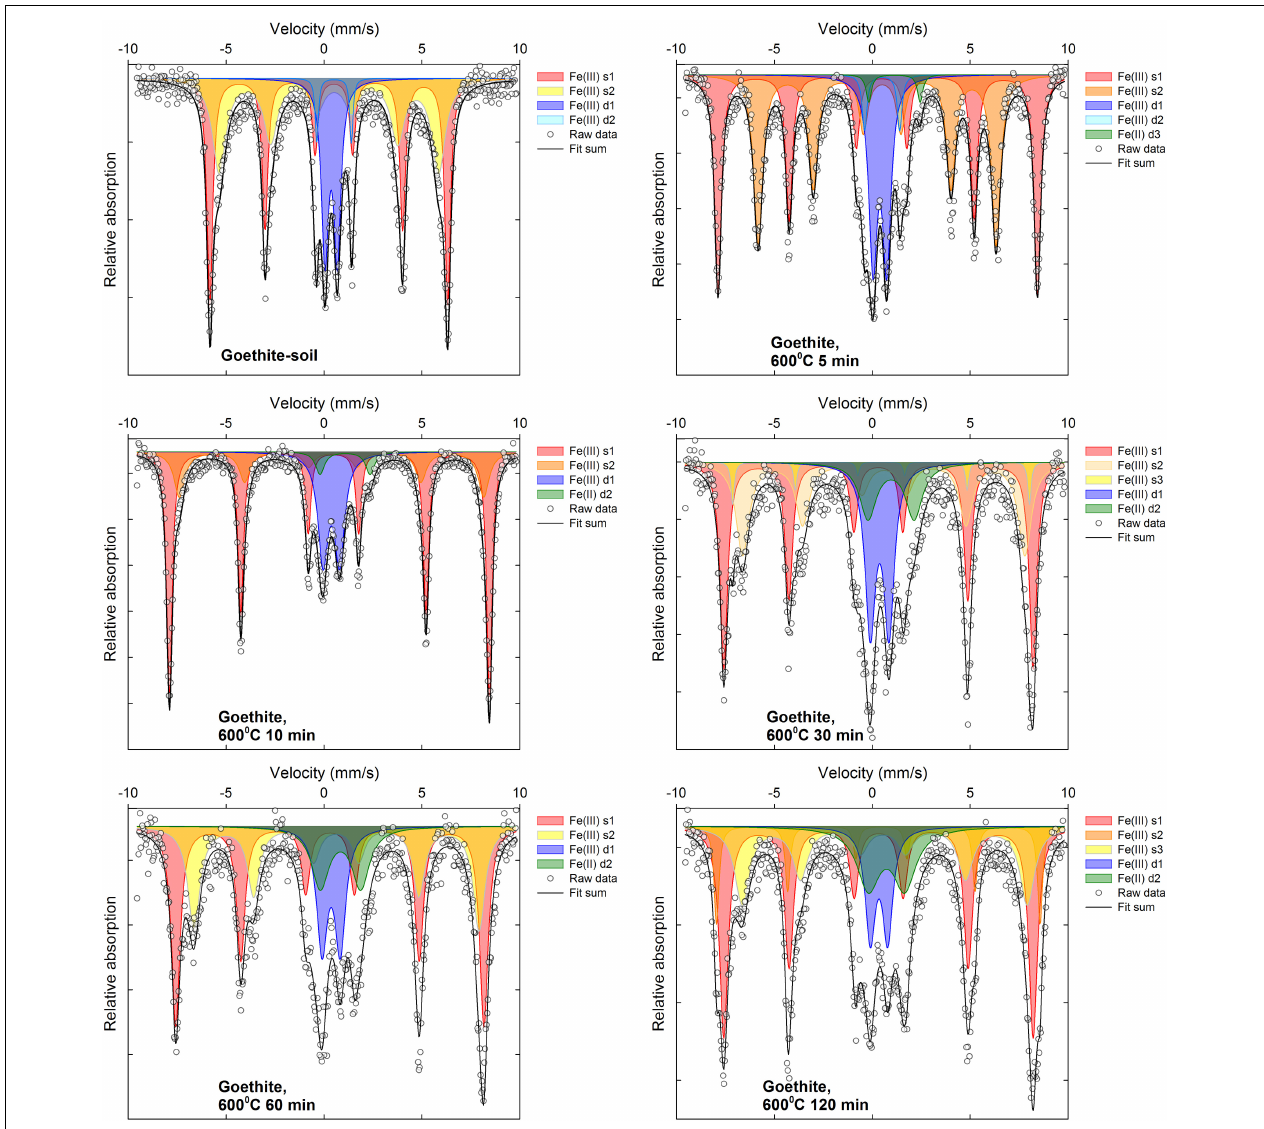
FIGURE 6 | Fitted 57 Fe Mössbauer spectra (292 K) for goethite:soil treatments, 600 ◦ C.